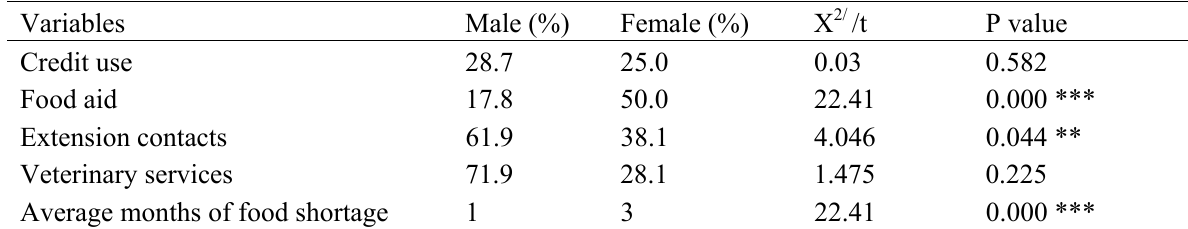
Table 5. Access to social service and source of income by